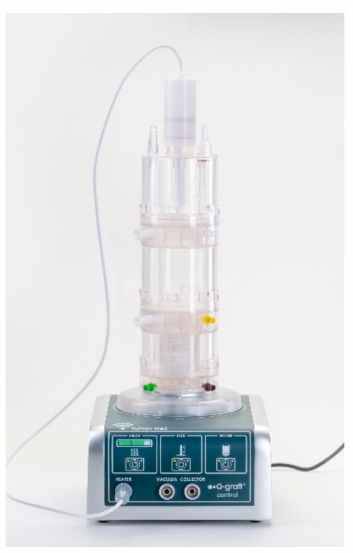
Figure 2. Separation system for regenerative cells from adipose tissue Q-graft ® (Human Med AG, Schwerin, Germany) consisting of the disposable part Q-graft ® collector (top) and the reusable control unit Q-graft ® control